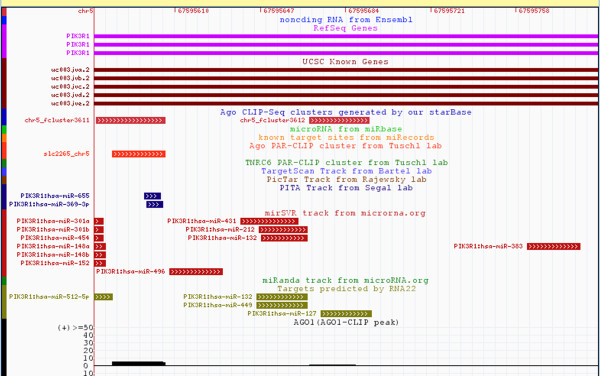
Illustrative screen shots from the deepView browser. The deepView browser provides an integrated view of CLIP-Seq data, known and predicted microRNA (miRNA) target sites, protein-coding genes, non-coding (ncRNA) genes, miRNAs, strand-specific peak clusters, genome-wide target-peaks and target-plots.